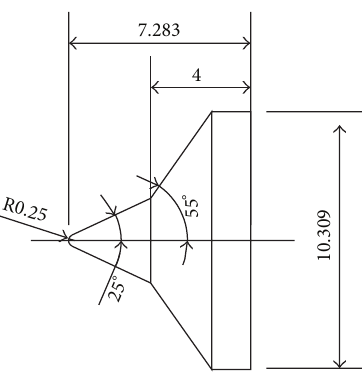
Figure 5: Number 2 configuration (in) (R0.25 blunt nose 25 ∘ /55 ∘ double